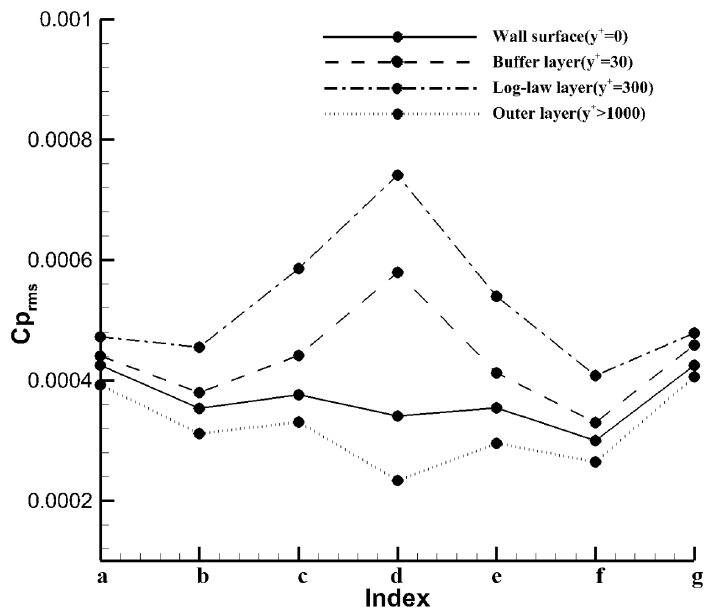
Figure 7. The distribution of Cp rms within boundary layer near limiting